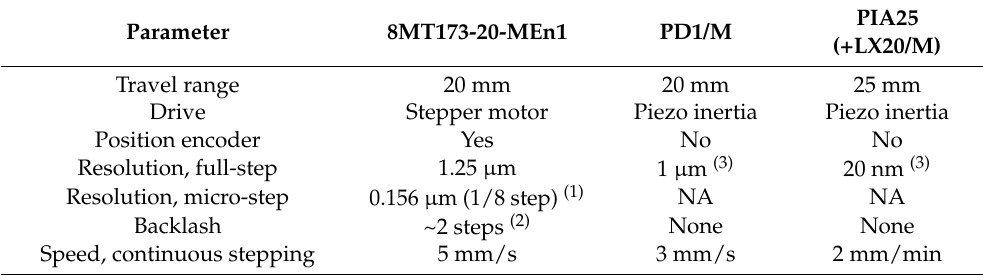
Table 2. Operational data for the linear translation stages used in this study. (1) xyz-assembly built with encoded stepper-motor-driven stages 8MT173-20-MEn1 ( Standa ); driver: three-axis controller 8SMC5-USB-B8-B9 ( Standa ); and (2) xyz-assembly based on piezo-inertia translators